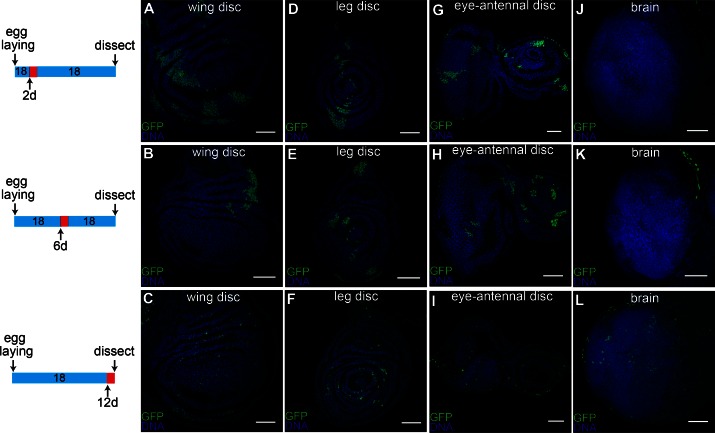
Timing of caspase activation in larval tissues.Larvae with CasExpress, G-trace and Gal80ts were grown at 18°C (blue in the timeline bars on the left) for 2d (A, D, G, J), 6d (B, E, H, K), or 12d (C, F, I, L), shifted to 29°C (red in the timeline bars) for 1d, then kept at 18°C until late third instar. Induction of GFP expression occurs in wing discs (A–C), leg discs (D–F) and eye-antennal discs (G–I) throughout the larval stage; whereas few cells in brain (J–L) survive caspase activation before third instar. Scale bars are 50 μm.